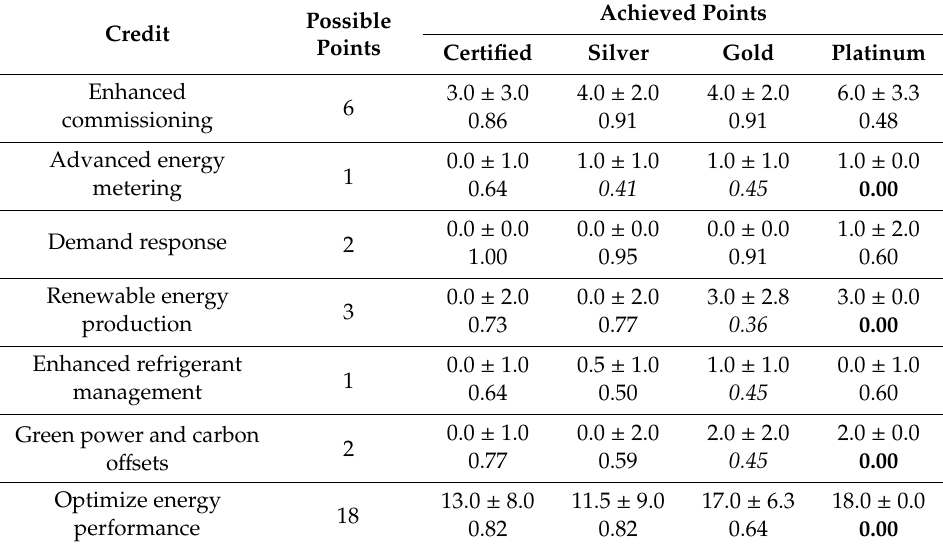
Table 5. Credit points achieved for Energy and Atmosphere category of LEED-NCv4